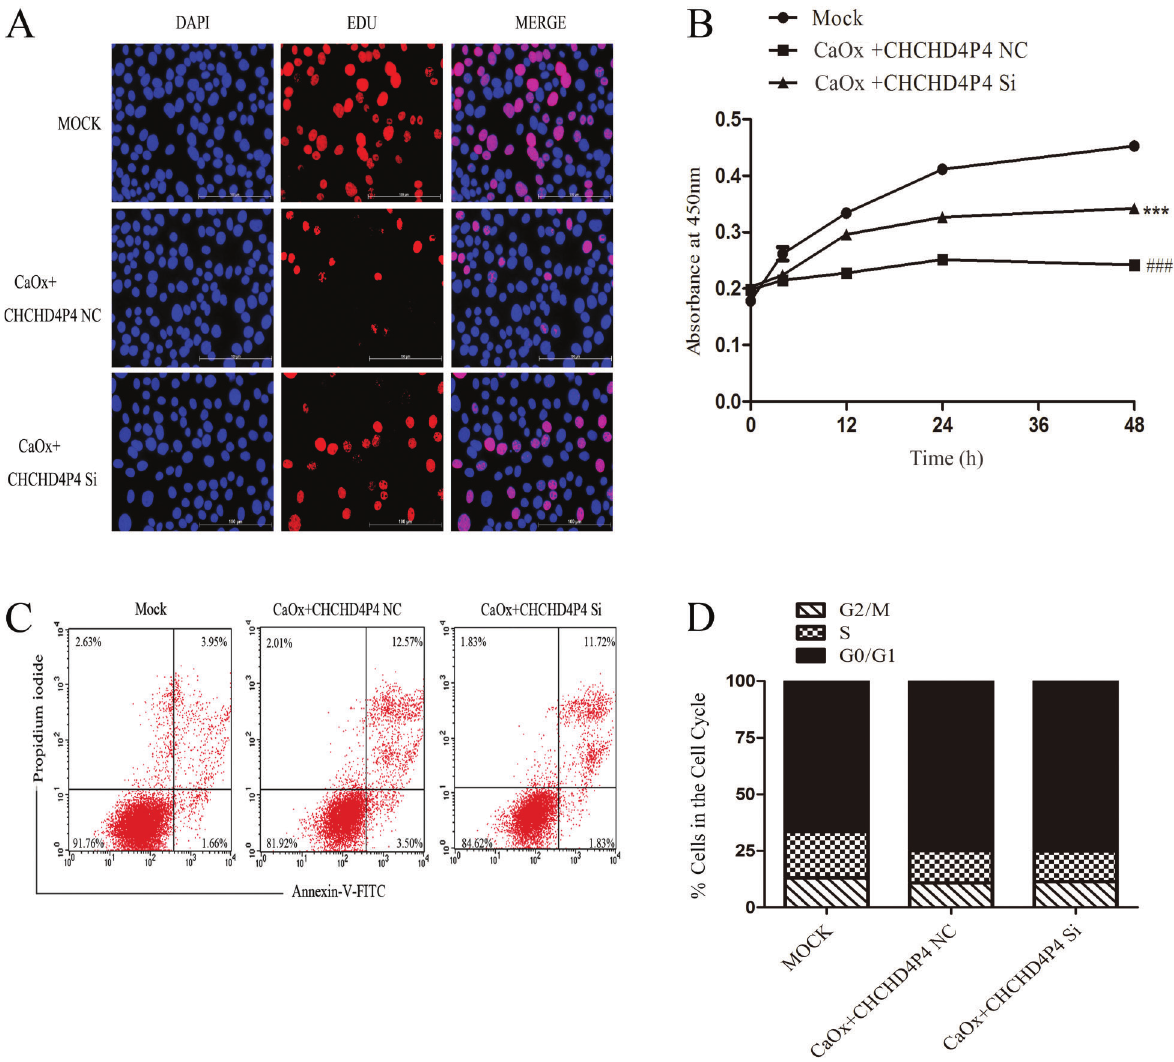
Figure 7. Effect of CHCHD4P4 on the cell cycle of HK-2 cells. Immuno fl uorescence microscopic analysis of 5-ethynyl-2 ’ -deoxyuridine (EDU) ( A ) in the indicated HK-2 cell clones. Scale bars = 100 m m. Blue represents the nucleus, and red indicates the proliferation of cells. The CCK8 assay ( B ) was used to assess HK-2 cell proliferation (***P o 0.001 vs mock treatment, ### P o 0.001 vs COM + CHCHD4P4 NC, t -test). Annexin V fl ow-cytometric analysis ( C ), and cell cycle progression ( D ) of the HK-2 cells that were transfected with the siRNA against